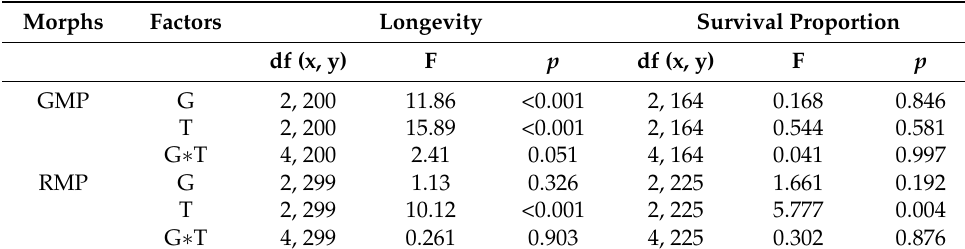
Table 5. Two-way ANOVA for the effects of growth periods (G) and treatments (T) on the longevity and survival proportion (SP) of green color morphs of pea aphids (GMP) and red color morphs (RMP) of pea aphids.